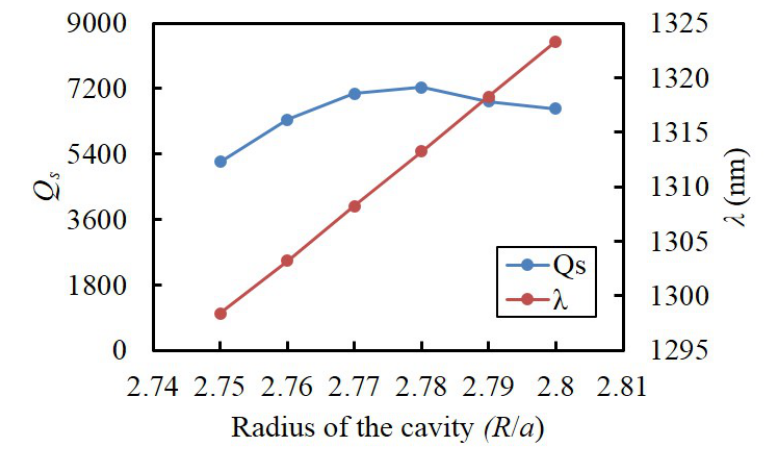
Figure 5. Resonant wavelength ( λ ) and quality factor ( Q s ) of CirD cavity dependent on radius of cavity ( R